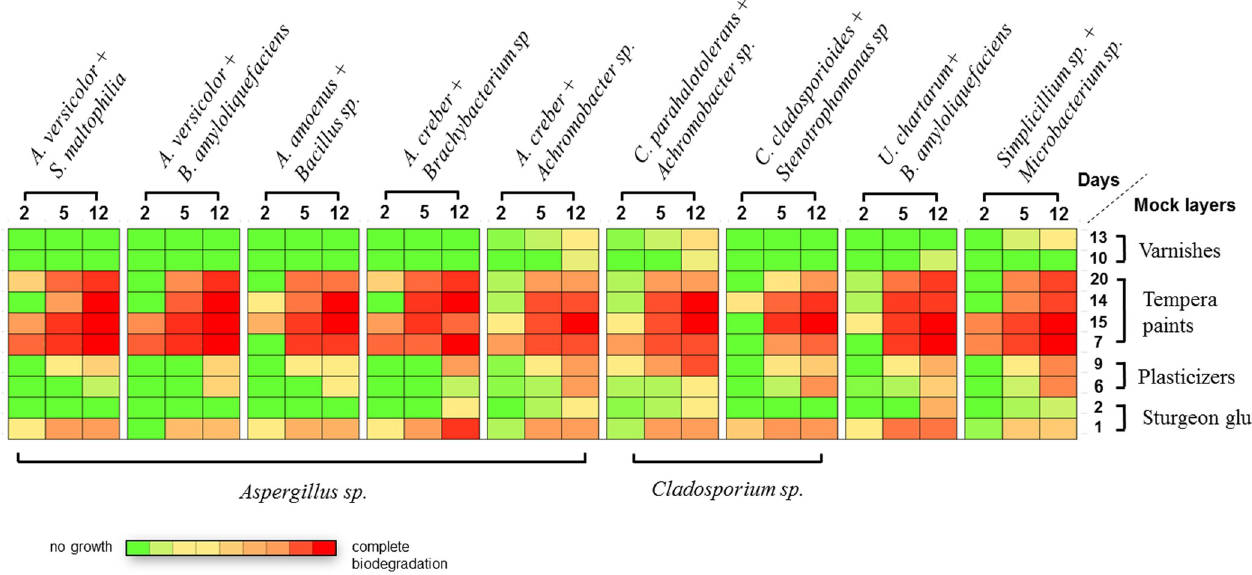
Fig 3. Culture growth on mock layers and biodeterioration dynamics. Mock layers (indicated on the right) were inoculated with microorganisms (indicated on the top), incubated for 2, 5, or 12 days at 25˚C, and analyzed for microbial growth.